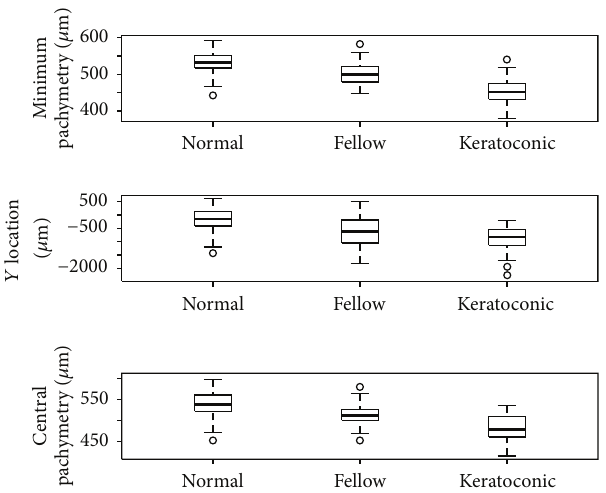
Figure 1: Values recorded for the variables Min, Y location, and CCT in the three study